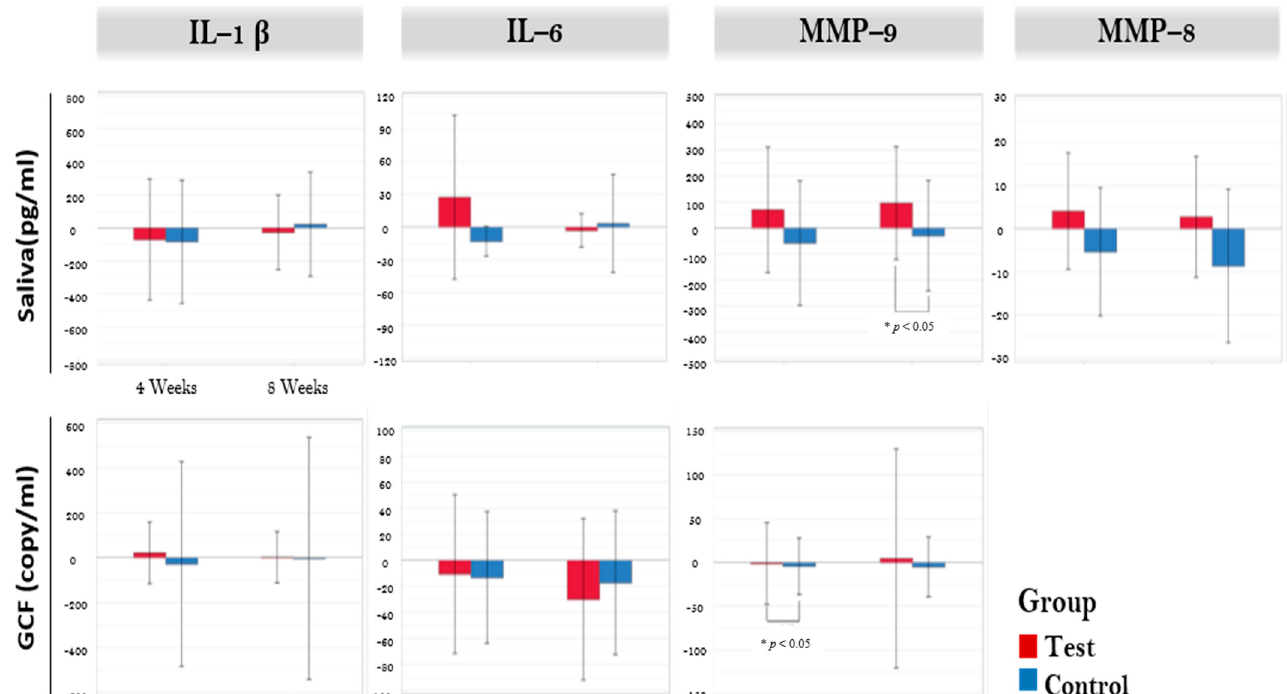
Figure 2. Biomarkers in salivary sample and gingival crevicular fluid. * Significant difference between test and control ( p < 0.05). GCF: gingival crevicular fluid, IL-1 β : Interleukin-1 β , IL-6: interleukin-6, MMP-9: matrix metalloproteinase-9, MMP-8: matrix metalloproteinase-9.